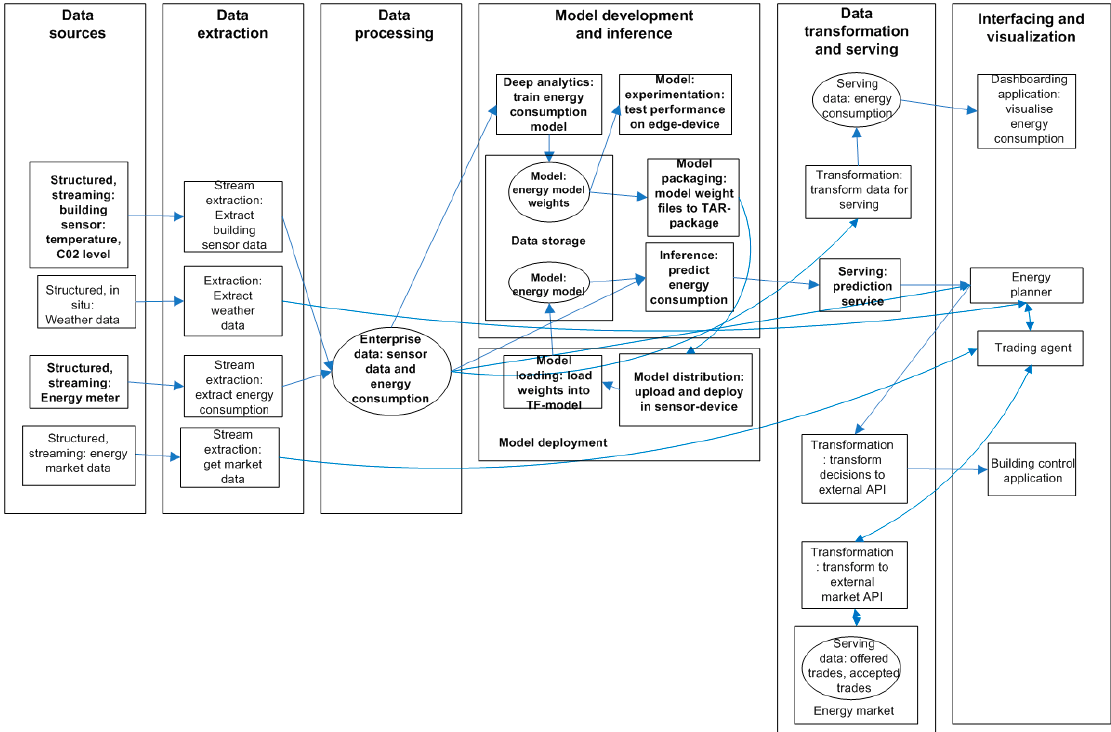
Figure 2. High-level data processing view of the architecture. The implemented elements have been described in bold.